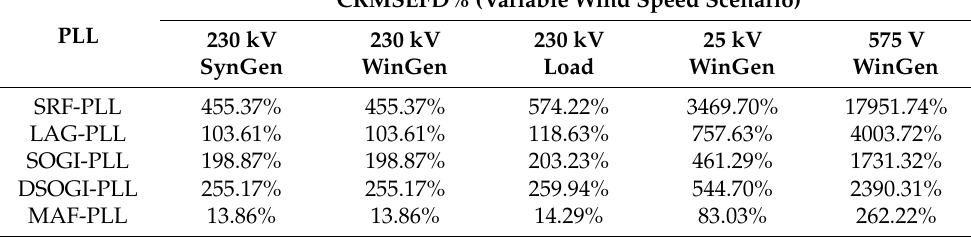
Table 9. Cumulative RMSEFD values for the PLLs located at different buses in the variable wind speed